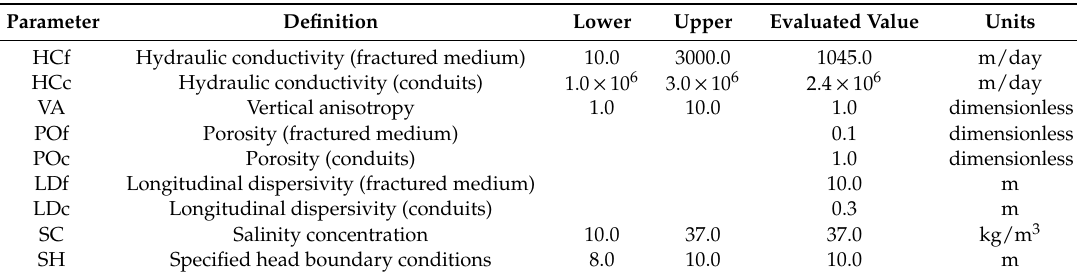
Table 1. Definitions of the parameters used in this paper, the specific evaluated values in the local sensitivity analysis and evaluation ranges (the lower and upper ones) of each parameter in the global sensitivity